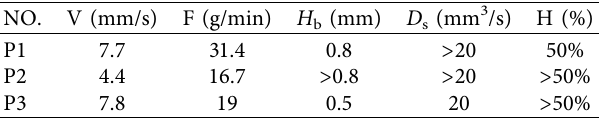
Table 3: Optimization results of diferent points (P1, P2, and P3) chosen in the operation window of Figure